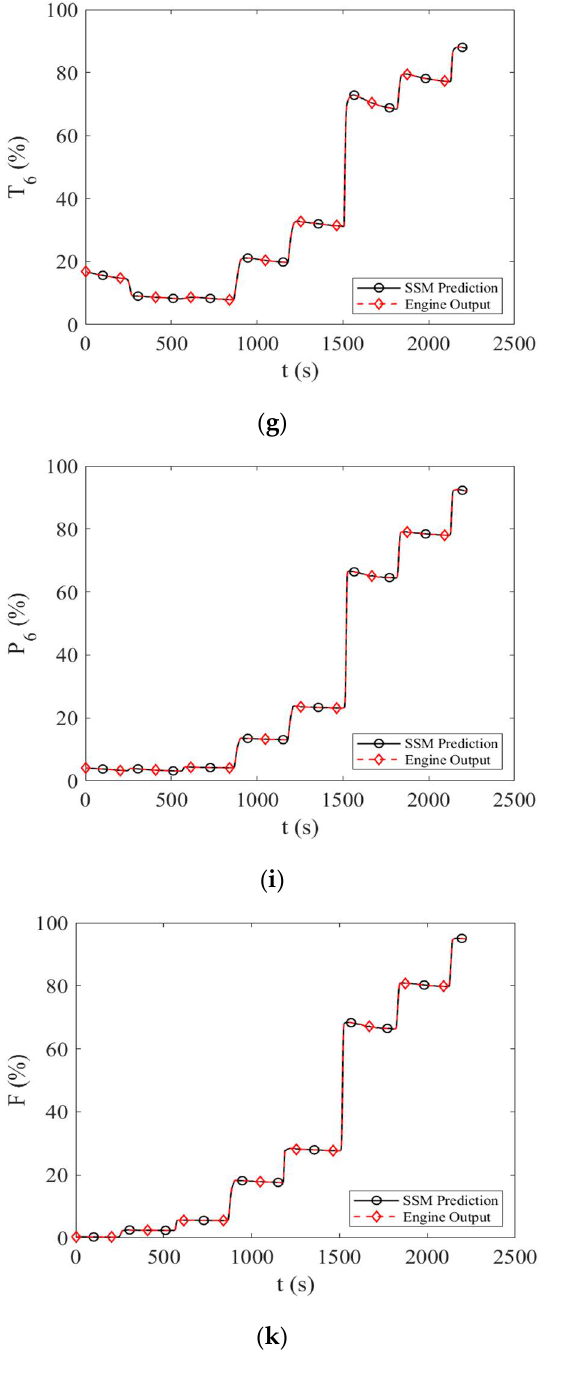
Figure 5. Prediction result of SSM at time k+5. ( a ) n 1 prediction; ( b ) prediction error of n 1 ; ( c ) n 2 prediction; ( d ) prediction error of n 2 ; ( e ) P 3 prediction; ( f ) prediction error of P 3 ; ( g ) T 6 prediction; ( h ) prediction error of T 6 ; ( i ) P 6 prediction; ( j ) prediction error of P 6 ; ( k ) F prediction; ( l ) prediction error of F.